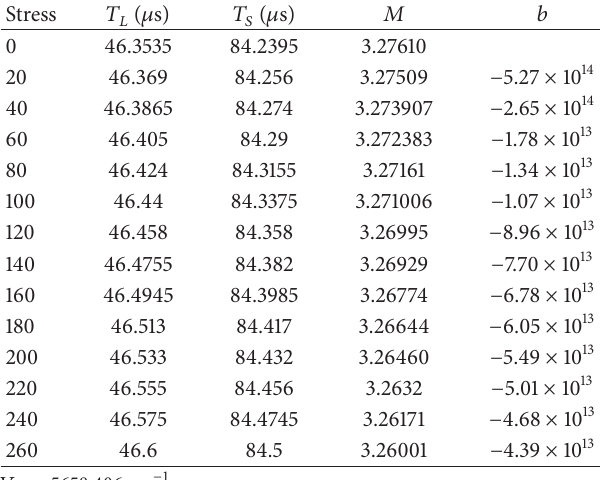
Table 1: Austenitic stainless steel bolt (A2-70) axial tensile stress measurement results.